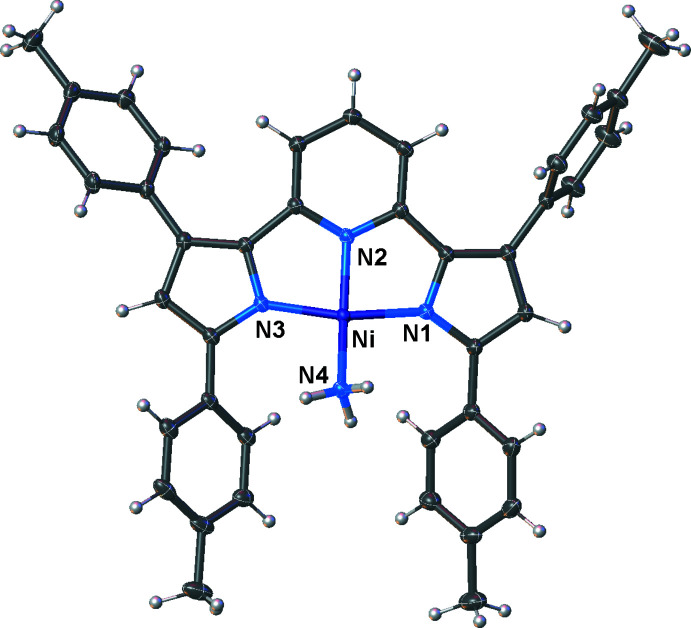
Mol­ecular structure of [pyrr2Py]Ni(NH3) with displacement ellipsoids drawn at the 50% probability level.